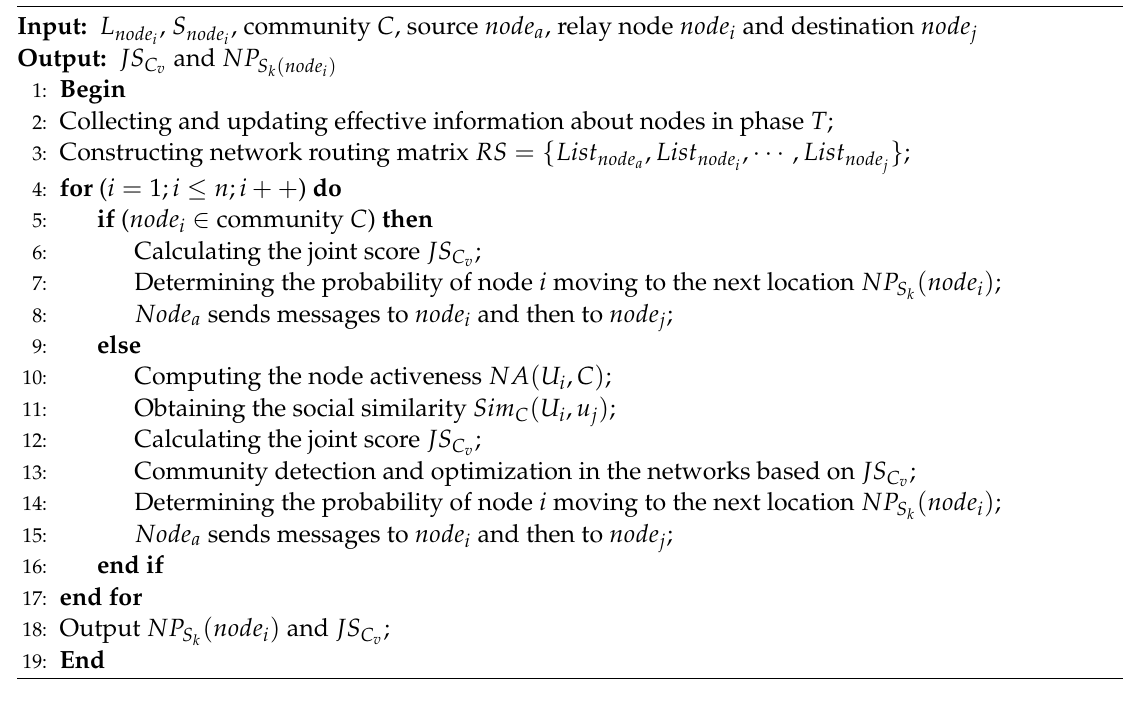
Algorithm 1 An Improved NPLP Routing-Forwarding